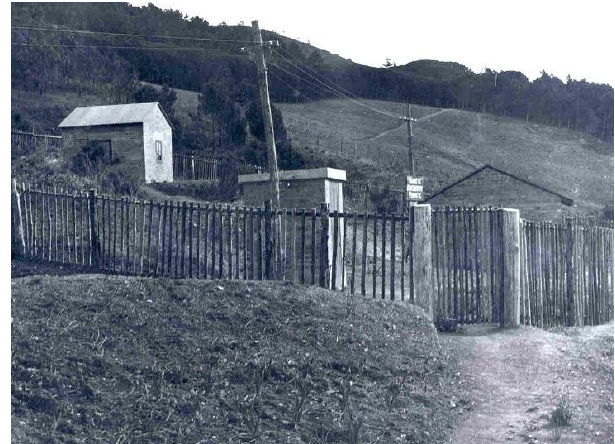
Figure 1. The magnetic observatory established close to the De- partment of Physics at the University of Cape Town in